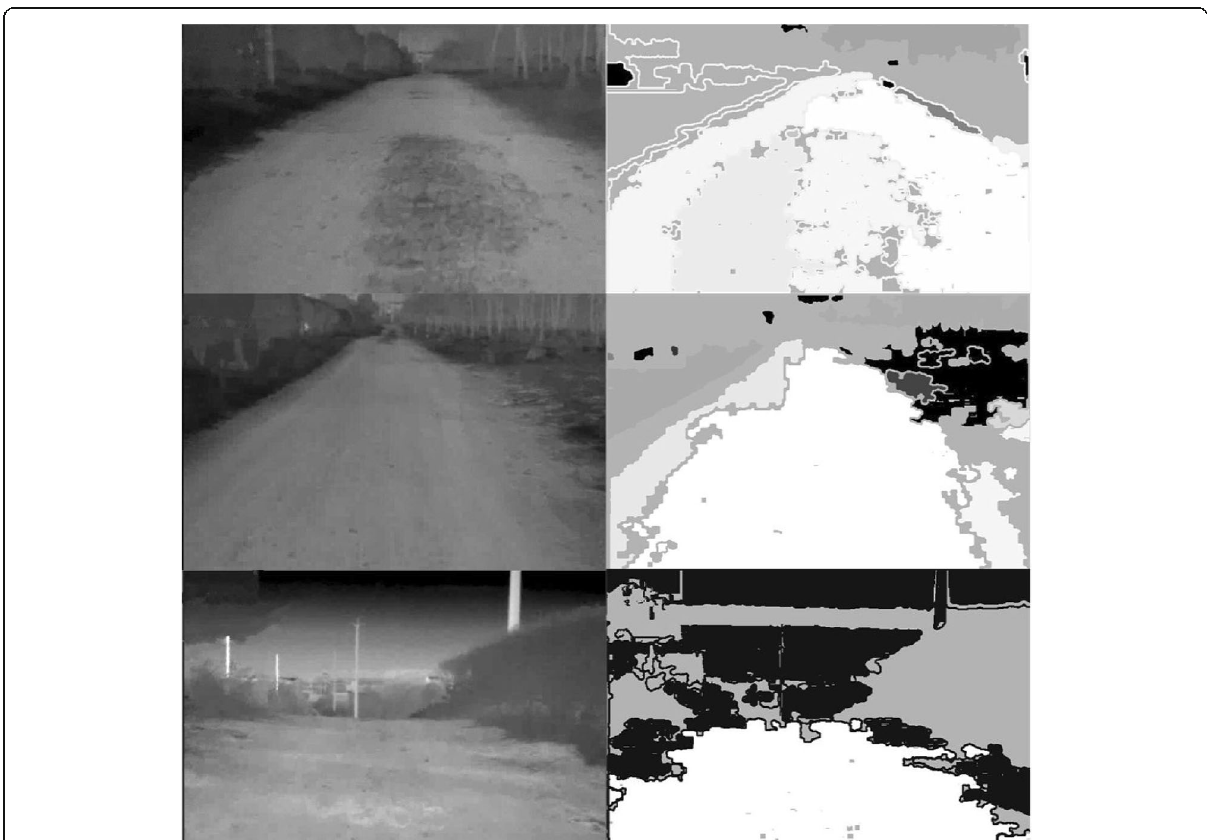
Fig. 8 Probability confidence maps. a Original image 1#. b Probability confidence map1#. c Original image 2#. d Probability confidence map 2#. e Original image 3#. f Probability confidence